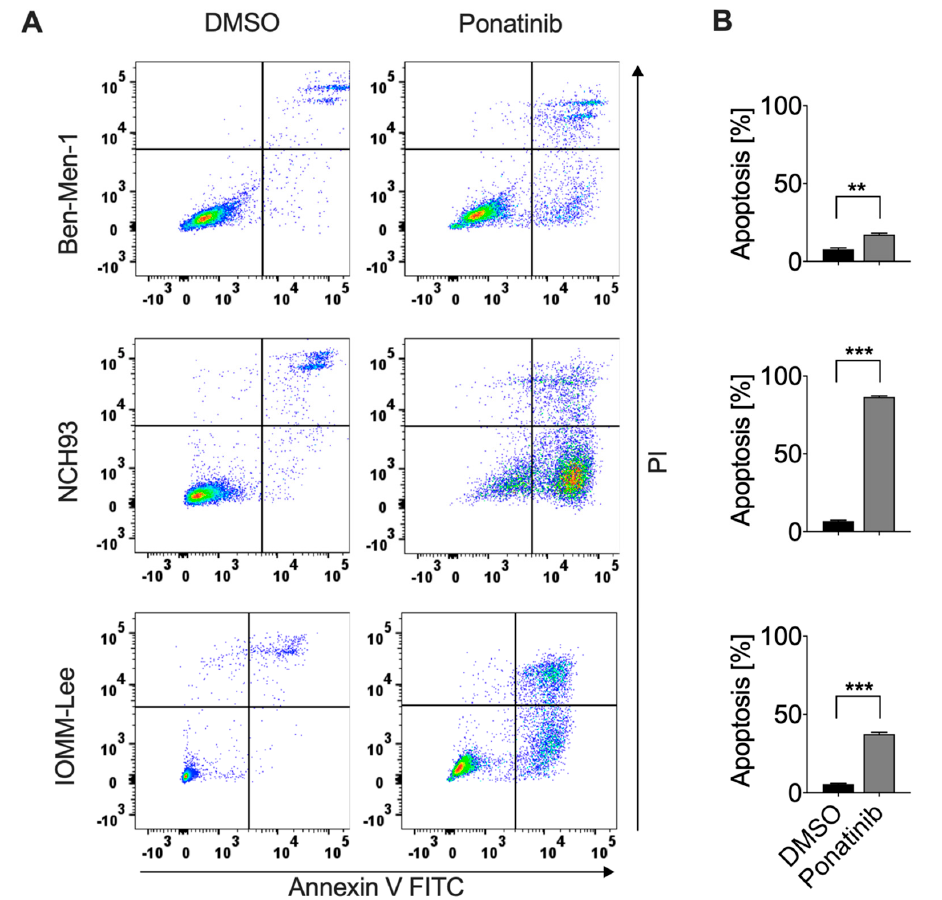
Figure 3. Ponatinib induced meningioma cell apoptosis: ( A ) Early- and late-stage apoptosis was induced after 72 h of treatment with 10 × IC50 of ponatinib. ( B ) Percentage of apoptotic cells in ponatinib-treated or DMSO-treated meningioma cells. The experiment was performed in triplicate and independently repeated three times. Results are expressed as mean± SEM. ** p < 0.01; *** p < 0.001.